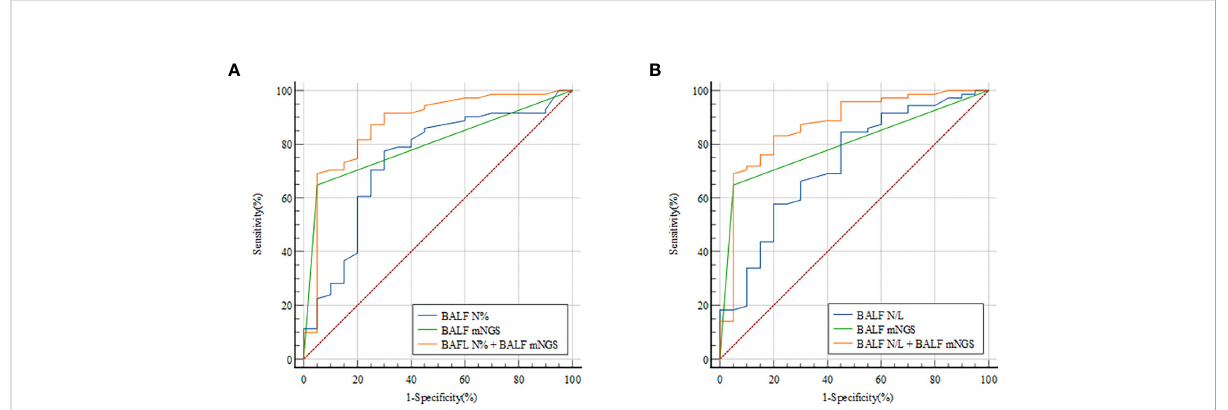
FIGURE 3 ROC curves for predicting PNID with BALF cellular analysis combined with mNGS. AUCs were 0.872 (95% CI 0.786 – 0.933) for BALF N% combined with BALF mNGS (A) and 0.871 (95% CI 0.784 – 0.932) for BALF N/L combined with BALF mNGS (B) . AUC, area under the curve; BALF, bronchoalveolar lavage fl uid; mNGS, metagenomic next-generation sequencing; N, neutrophils; N/L, ratio of neutrophils to lymphocytes; PNID, pulmonary non-infectious disease; ROC, receiver operating characteristic.